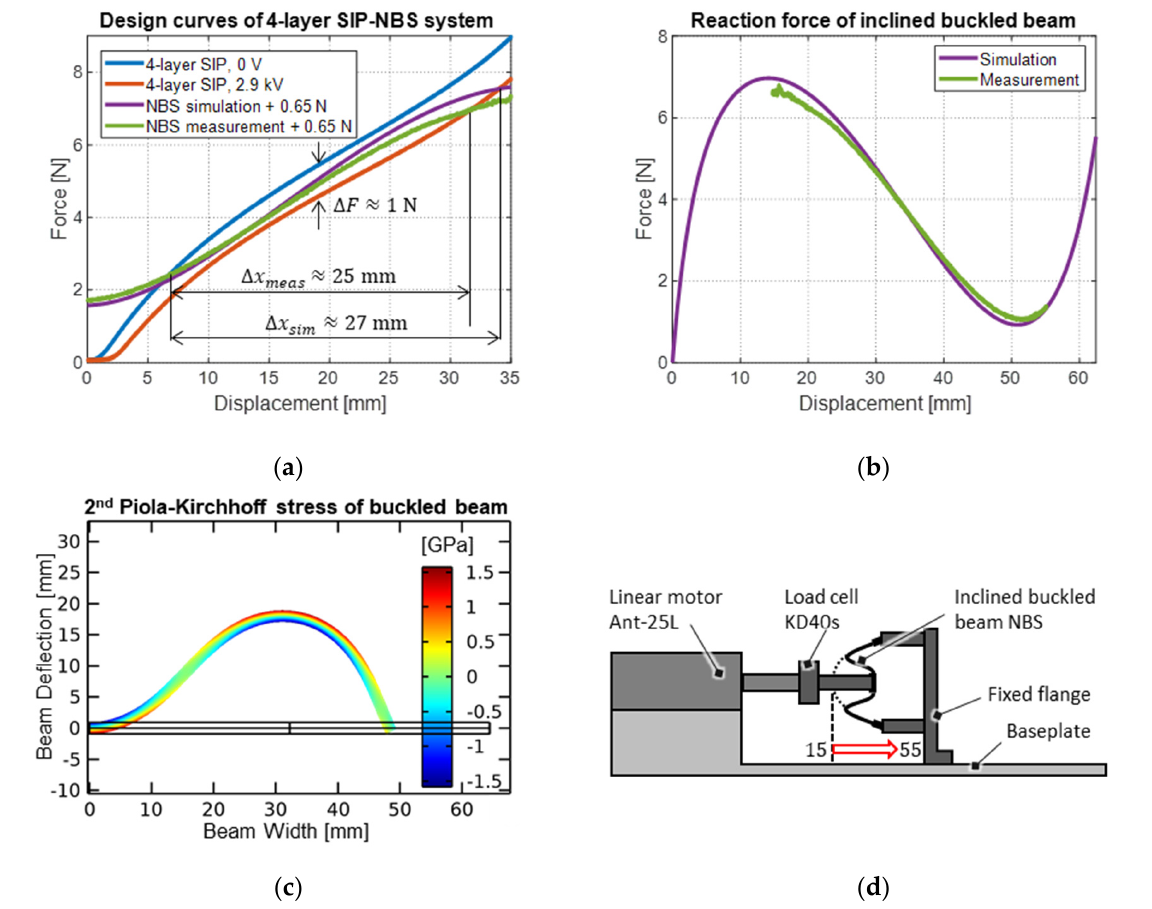
Figure 11. ( a ) SIP system design curves with the SIP working against inclined and centrally loaded buckled beam NBS and weight of moving components, with ( b ) comparison of FE-simulation to measurement results of the NBS reaction force, and ( c ) a detailed view of the mechanical stresses in the beam cross-section. ( d ) Schematic illustration of the beam characterization setup.